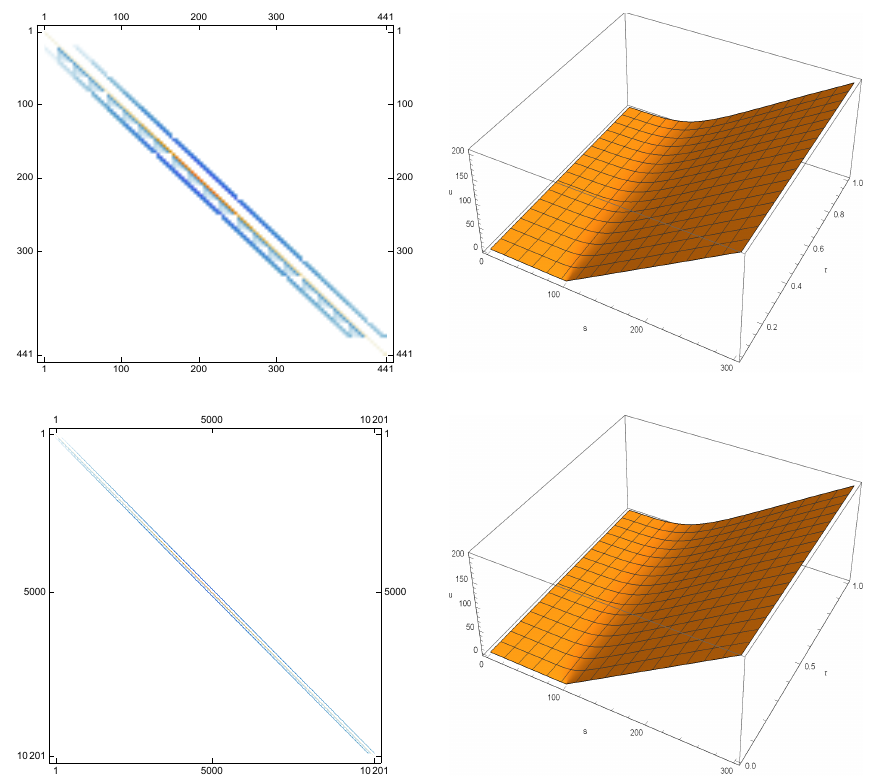
Figure 2. Numerical results in Test Problem 1 for PM. ( Top Left ) The sparsity pattern of the coefficient matrix in (35) based on m = n = 21. ( Top Right ) Time fractional option pricing curve. ( Bottom Left ) The sparsity pattern of the coefficient matrix in (35) based on m = n = 101. ( Bottom Right ) Time fractional option pricing curve.